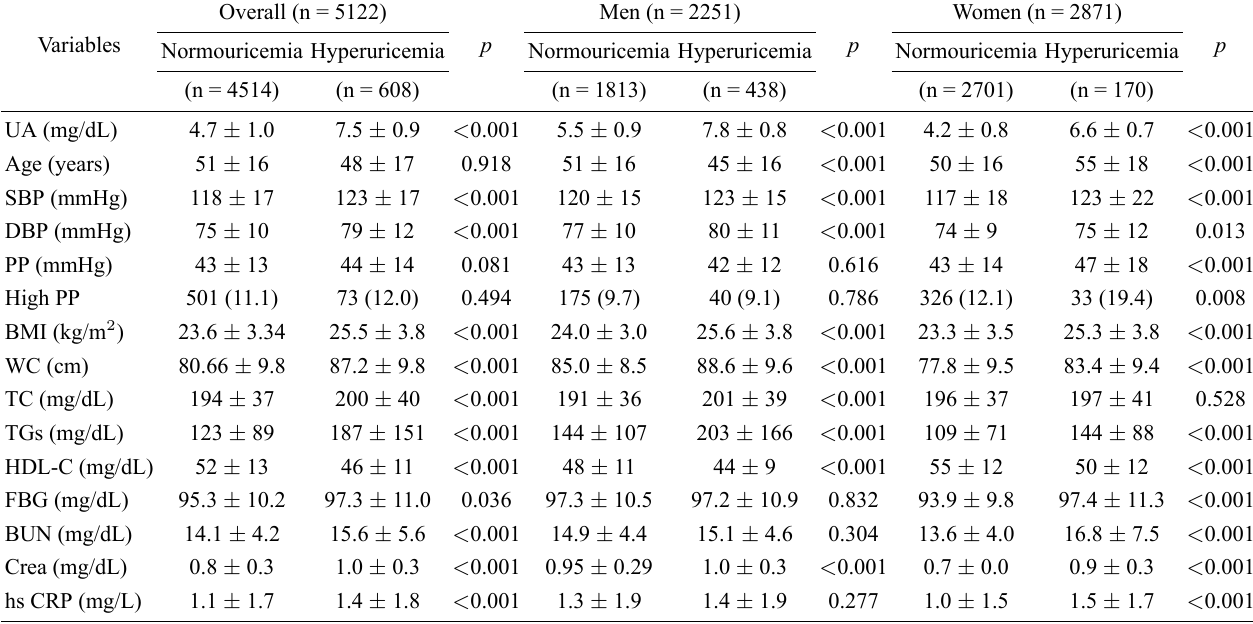
Table 2. General clinical characteristics according to uric acid in men and women (n (%), Mean ± SD).